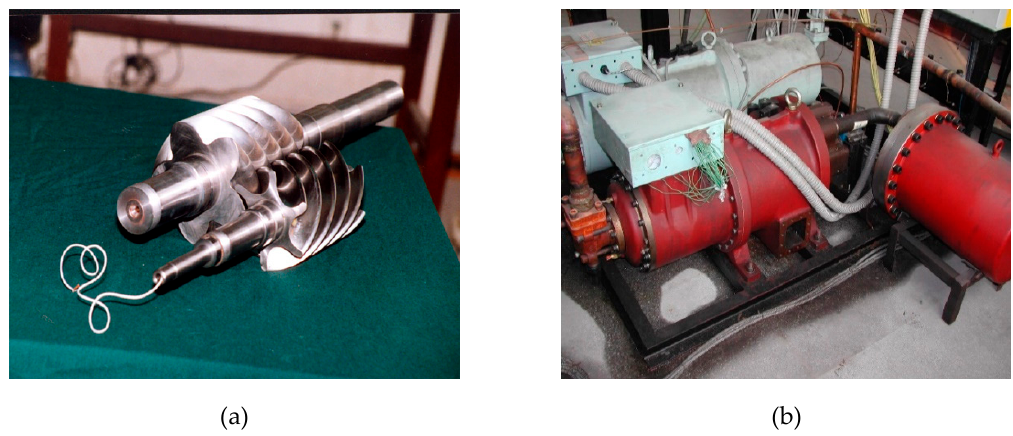
Figure 5. Experimental device. ( a ) Pressure sensor in the female rotor . ( b ) Experimental test